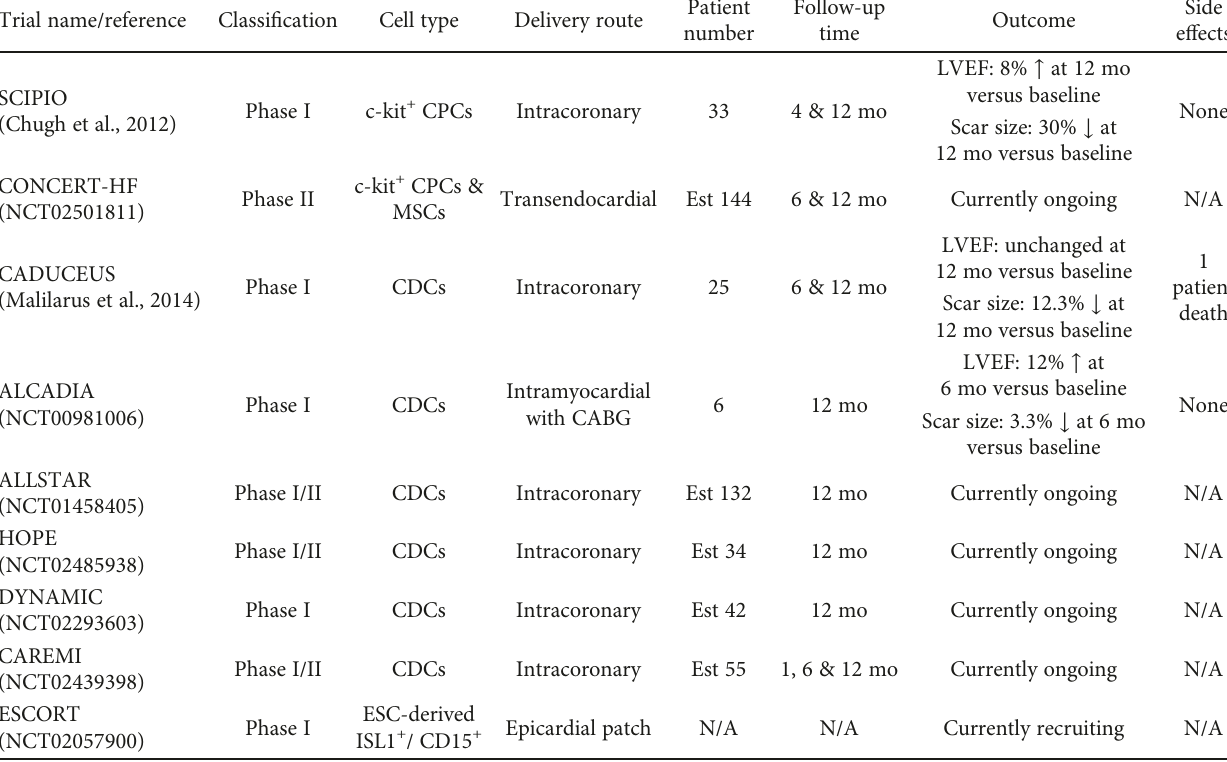
Table 1: Selected clinical trials employing CPC therapy for cardiac regeneration against ischemic